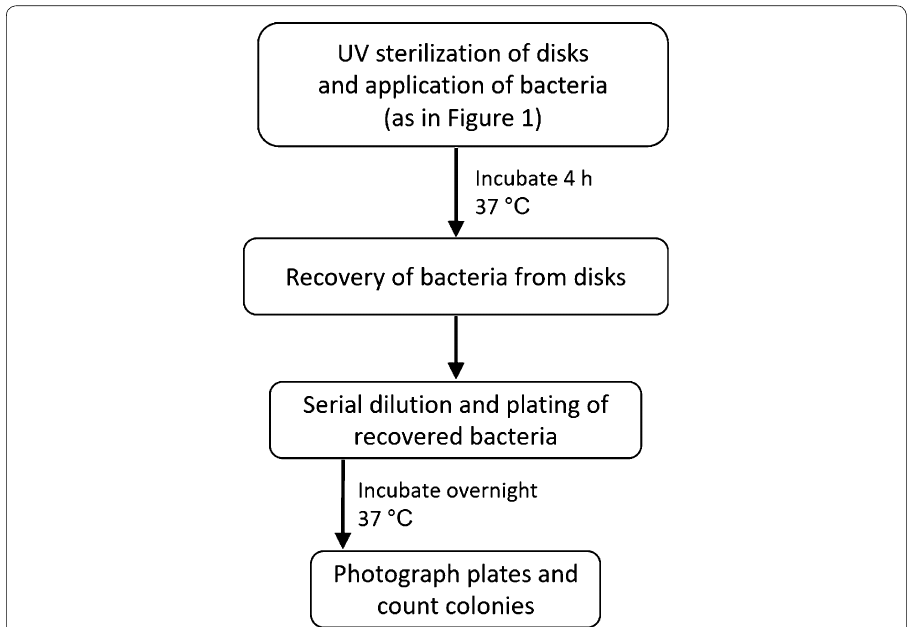
Fig. 2 Schematic overview of the test method. The test method runs over 2 days. On the morning of day 1, samples are sterilized with UV light and bacteria are applied before a 4 h incubation. In the afternoon of day 1, bacteria are recovered from samples, serially diluted, and applied to TSA plates. The TSA plates are incubated overnight, and are photographed the following